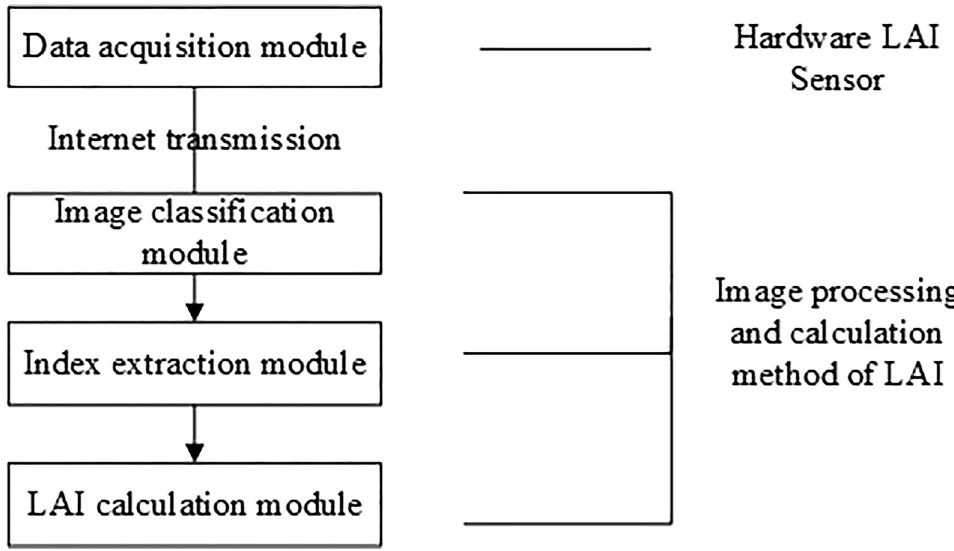
Figure 4. Flow chart of leaf area index measurement system based on WSN.